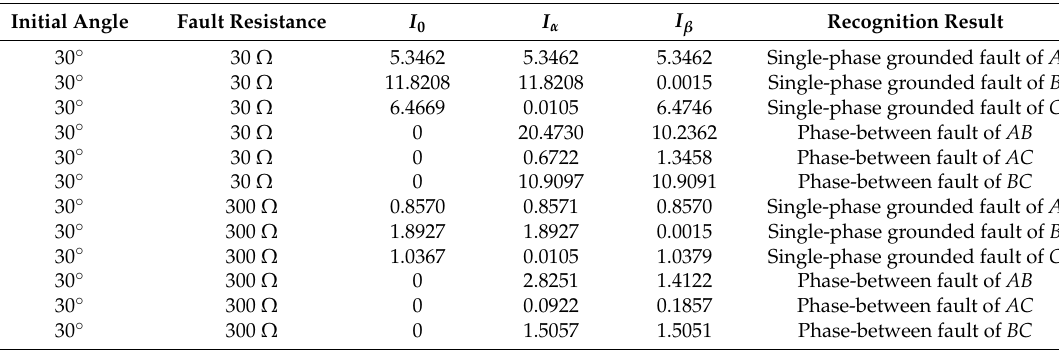
Table 6. DMWC recognition with different fault resistances.